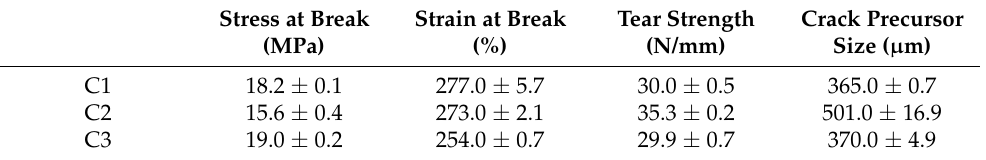
Table 4. Mechanical properties and crack precursor size for the tested